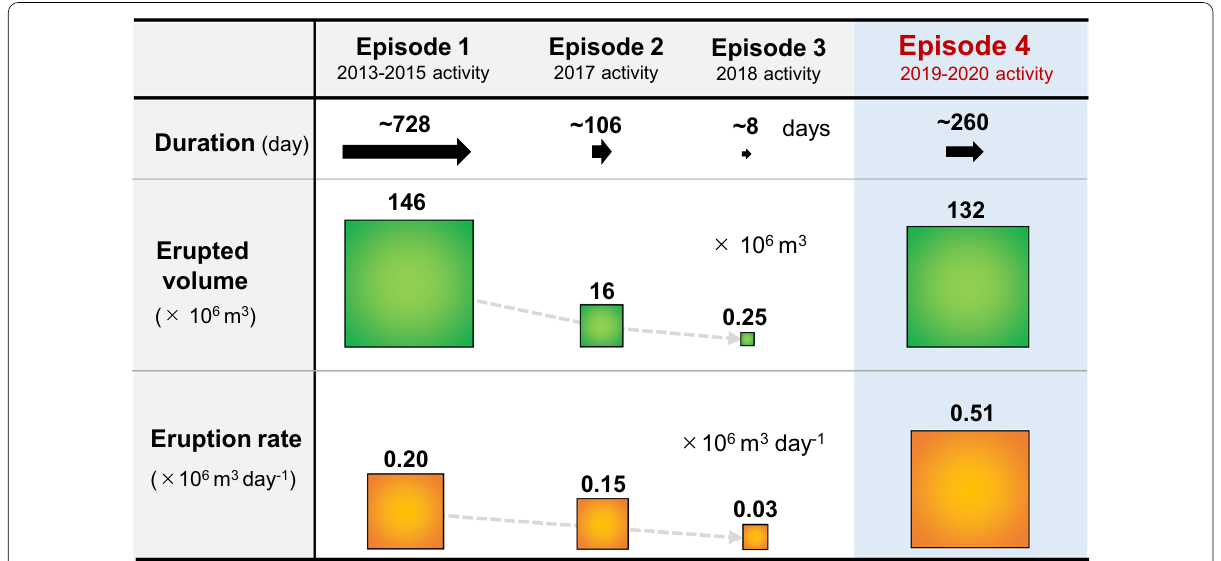
Fig. 6 Comparison of activity period, erupted volume and eruption rate for Episode 4 and Episodes